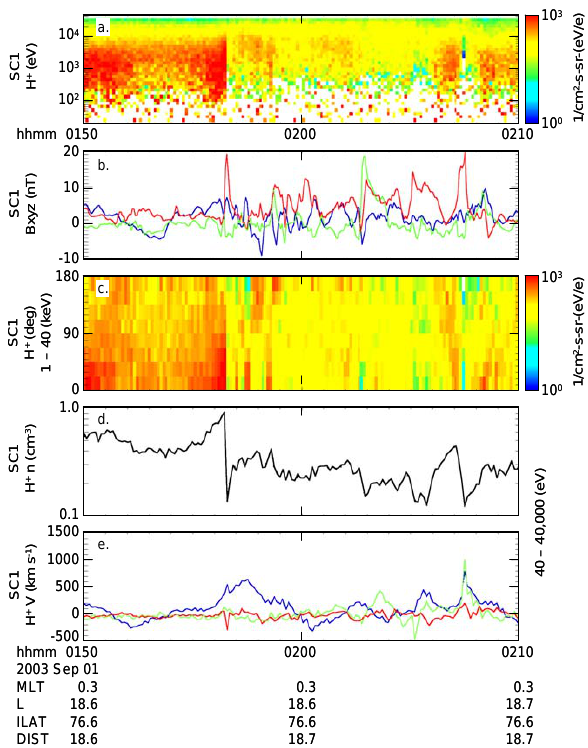
Fig. 5. 20-minute interval of SC 1 observations near the apogee of a different orbit (in 2003). (a) Flux versus time and energy. (b) GSE magnetic field components x (blue), y (green), and z (red). (c) Flux versus time and pitch angle (1 − 40 keV average). (d) Proton density. (e) GSE proton bulk flow components x (blue), y (green), and z (red) (cf. Table 1).